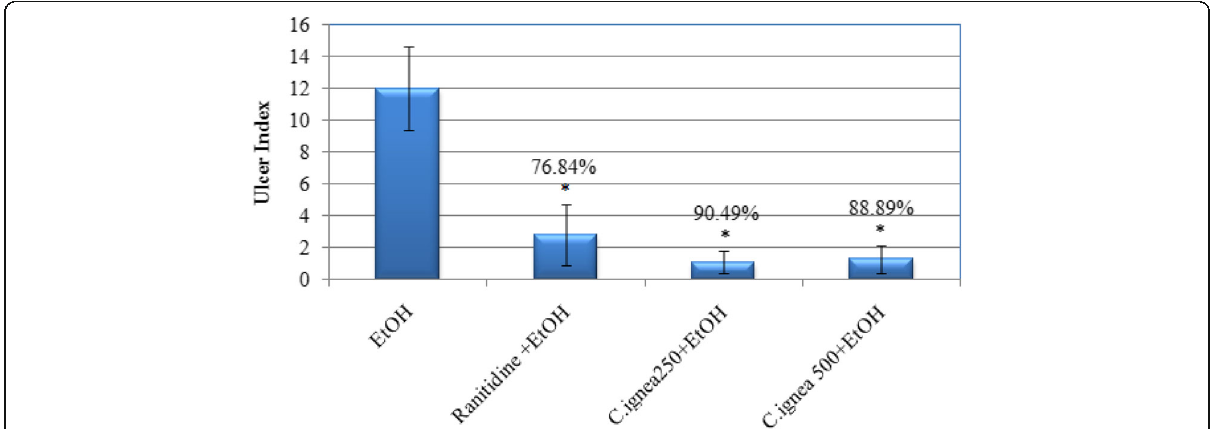
Fig. 3 Effect of C. ignea aerial parts extract on ulcer index and preventive index in ethanol ulcerated rats. Each value represents the mean ± SD for six rats in each group. * p < 0.05 is significantly different from ethanol